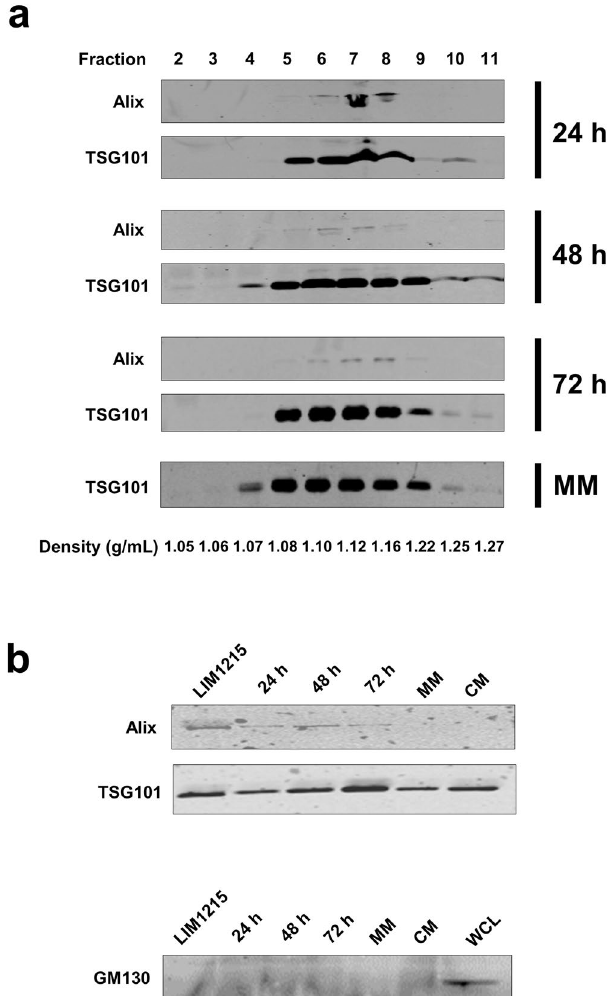
Figure 1. Western blot analysis of exosomes isolated from MM and colostrum. ( a ) Western blot analysis of fractions of increasing density obtained from the OptiPrep density gradient centrifugation which were probed for exosomal markers Alix and TSG101. TSG101 was identified in all the samples from fractions 5–9 corresponding to the buoyant density of 1.08–1.22 g/mL. The presence of Alix was limited to colostrum samples only. ( b ) Western blot analysis revalidating the presence of Alix in higher abundance only within colostrum exosomes as compared to mature milk (MM) and commercial milk (CM). TSG101 was found in all the samples including commercial milk exosomes. Exosomes isolated from LIM1215 colorectal cancer cells (LIM1215) was used as a positive control. GM130 was detected in LIM1215 colorectal cancer cell lysates (WCL) and was absent in the milk derived exosomal samples confirming the depletion of contaminating vesicles arising from